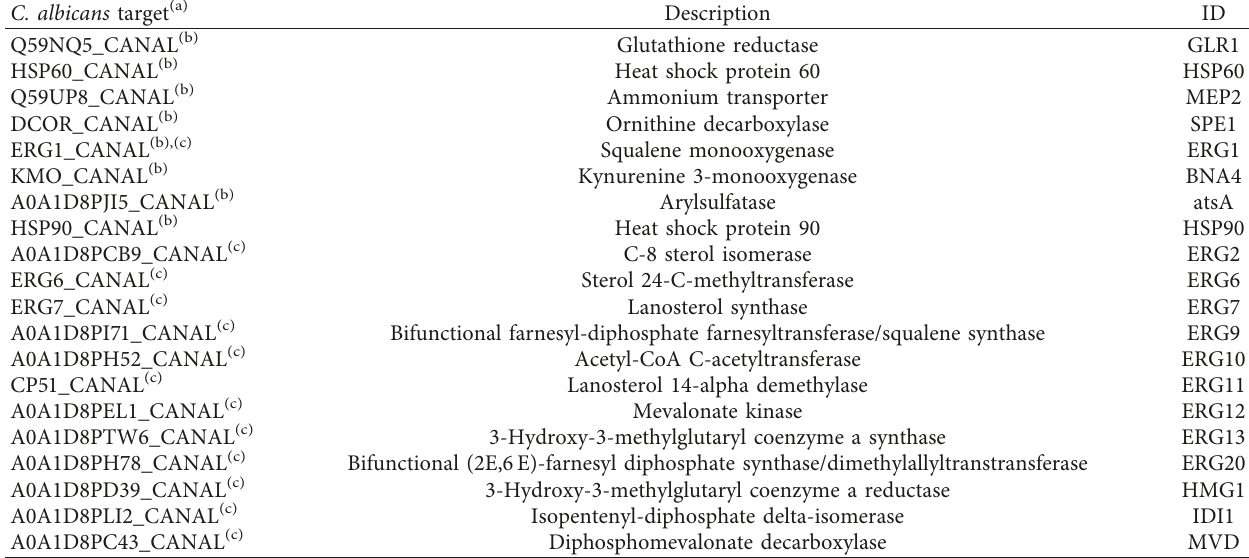
Table 3: Potential targets of compound 2 in C. albicans selected for modeling